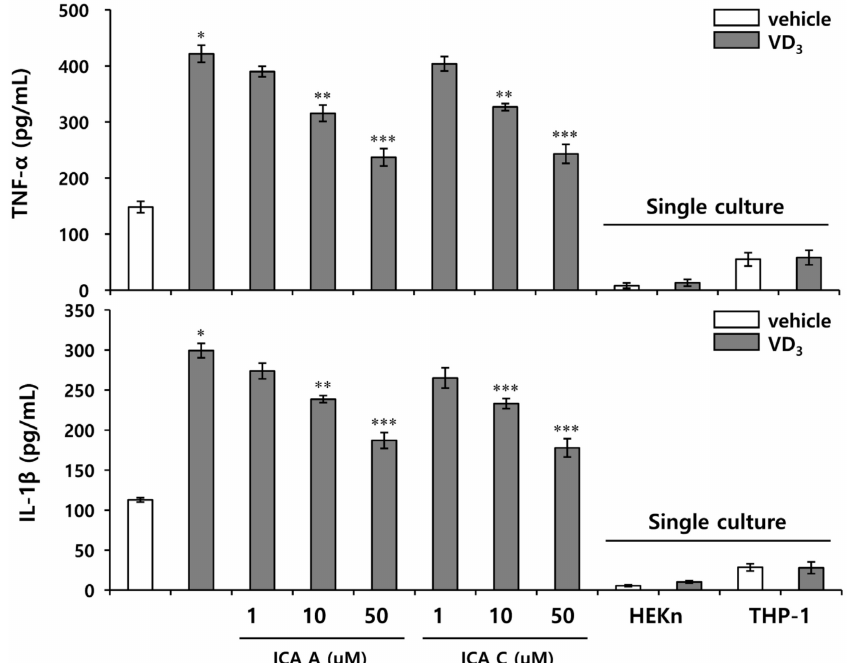
Figure 4. Chlorogenic acid isomers inhibit the expression of proinflammatory cytokines induced by VD 3 in HEKn/THP-1 co-culture. HEKn were seeded on upper insert chambers, and THP-1 was seeded on lower chamber in the two-compartment transwell system for 24 h. Upper insert was pretreated with 1, 10, or 50 µ M isochlorogenic acids A and isochlorogenic acid C, respectively, for 1 h, followed by treatment with 200 nM VD 3 . After 72 h incubation, the secreted pro-inflammatory cytokines (TNF- α , IL-1 β ) were measured by ELISA. The results are expressed as mean ± standard deviation (SD) ( n = 3). * p < 0.01 vs. vehicle control; ** p < 0.05 vs. VD 3 -treated control; *** p < 0.01 vs. VD 3 -treated